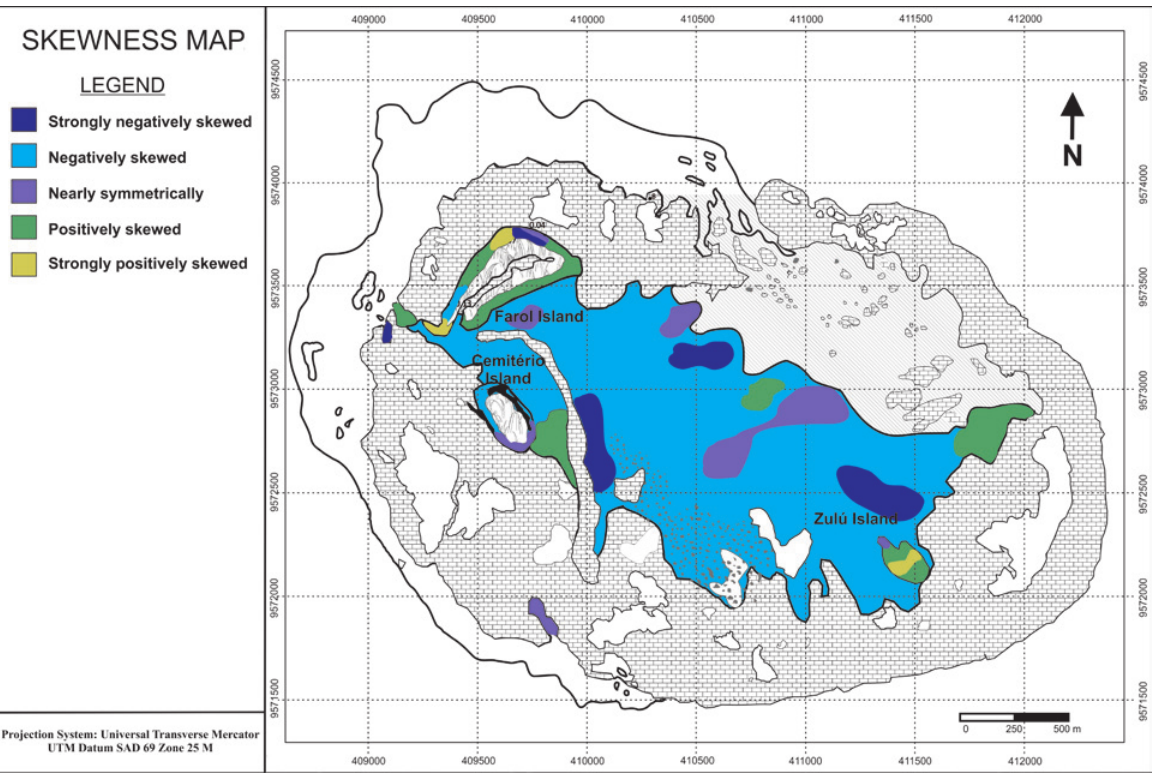
Figure 11 - Skewness map of Rocas